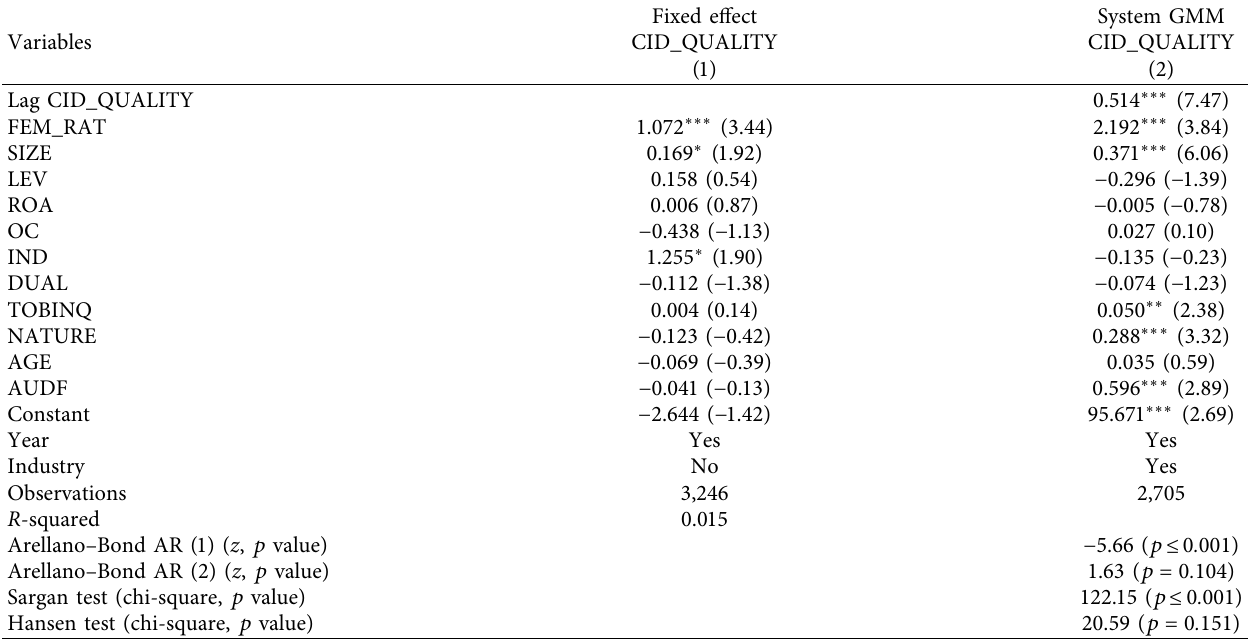
Table 10: Regression results of the fixed effect and system GMM